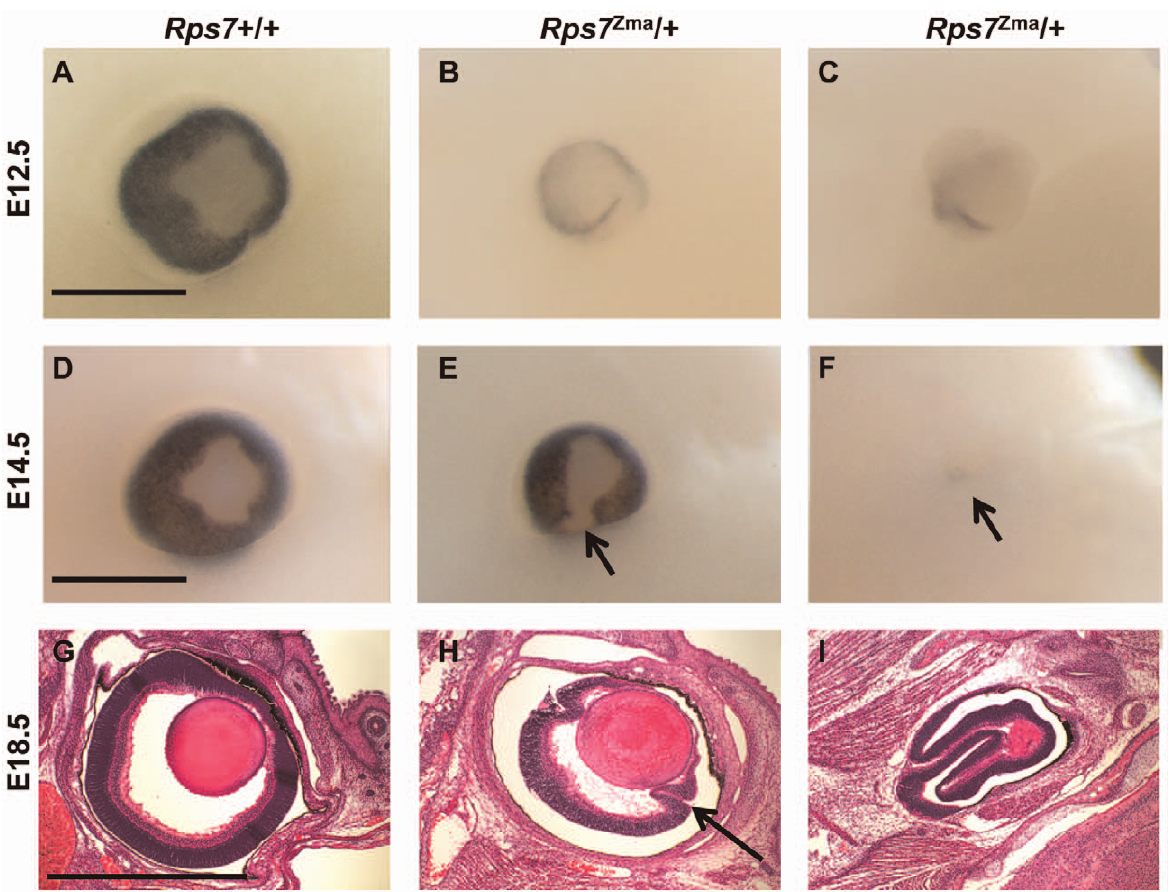
Figure 4. Eye dysmorphology in Rps7 mutants. Representative whole-mount images from one Rps7 + / + and two different Rps7 Zma / + embryos are shown at E12.5 (A–C) and 14.5 (D–F). In addition, H&E stained sagittal sections through the eye are shown for one Rps7 + / + and two different Rps7 Zma/ + embryos at E18.5 (G–I). The eye dysmorphology of Rps7 Zma / + mutants ranges in severity from minor unilateral or bilateral uveal coloboma (E, H) to severe microphthalmia resulting in disorganized eye structures (C, F, I). Arrows in E and F mark examples of coloboma and extreme microphthalmia, respectively. Arrow in H marks abnormal folding of the retinal layers. All images are oriented with anterior up, rostral to the right. Within each age group/row, all genotypes are shown at the same magnification. Scale bars=0.5 mm.